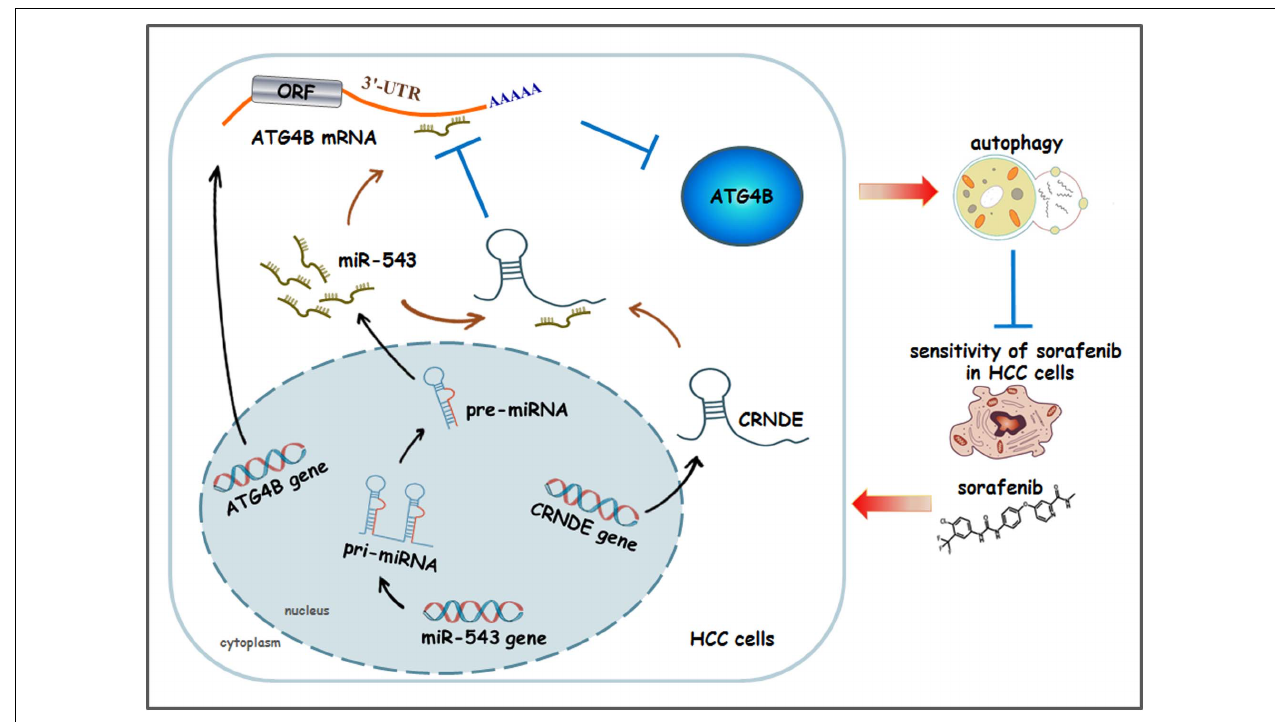
FIGURE 8 | The schematic model illustrating how CRNDE induces autophagy and alleviates the anti-HCC effect of sorafenib. In this model, CRNDE sequestrates miR-543 and subsequently enhances ATG4B mRNA stability, leading to upregulaion of ATG4B and promotion of autophagy. Moreover, sorafenib activates CRNDE/ATG4B/autophagy pathway, which ultimately attenuates the sensitivity of sorafenib in HCC